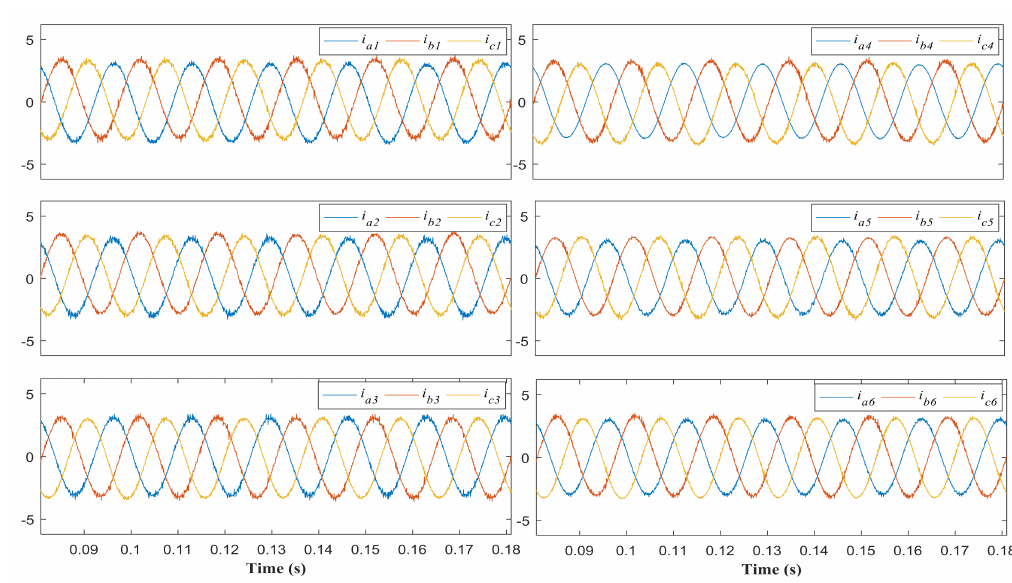
Figure 13. Three-phase load currents.